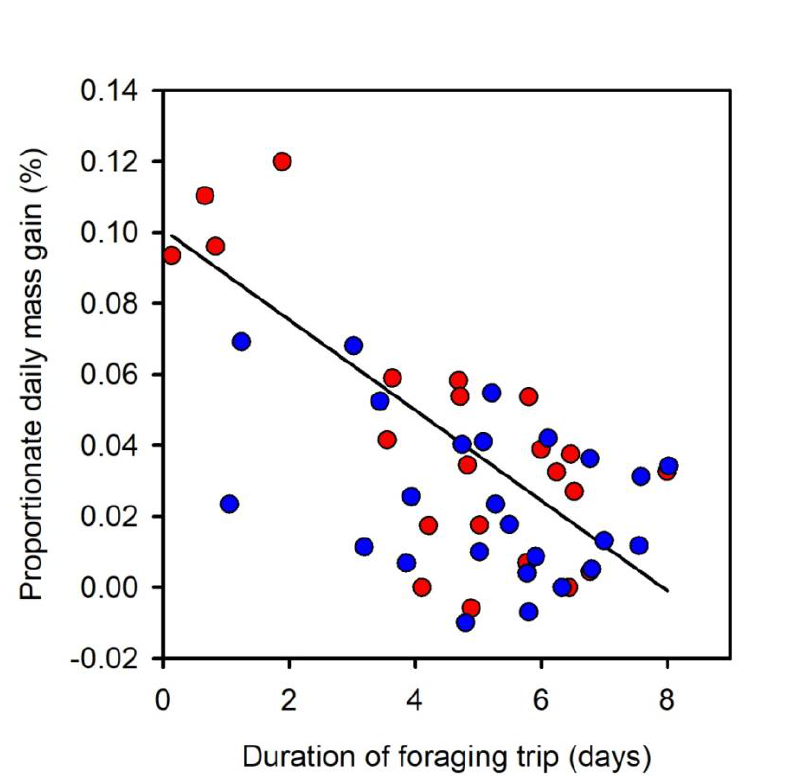
Figure 6. Foraging efficiency (proportionate daily mass gain while foraging) as a function of the total duration of the foraging trip for male (blue) and female (red and solid line) snow petrels sampled at Ile des Pétrels, Adélie Land, East Antarctica. For females: F 1,20 =25.349, P<0.001, R² = 0.559.